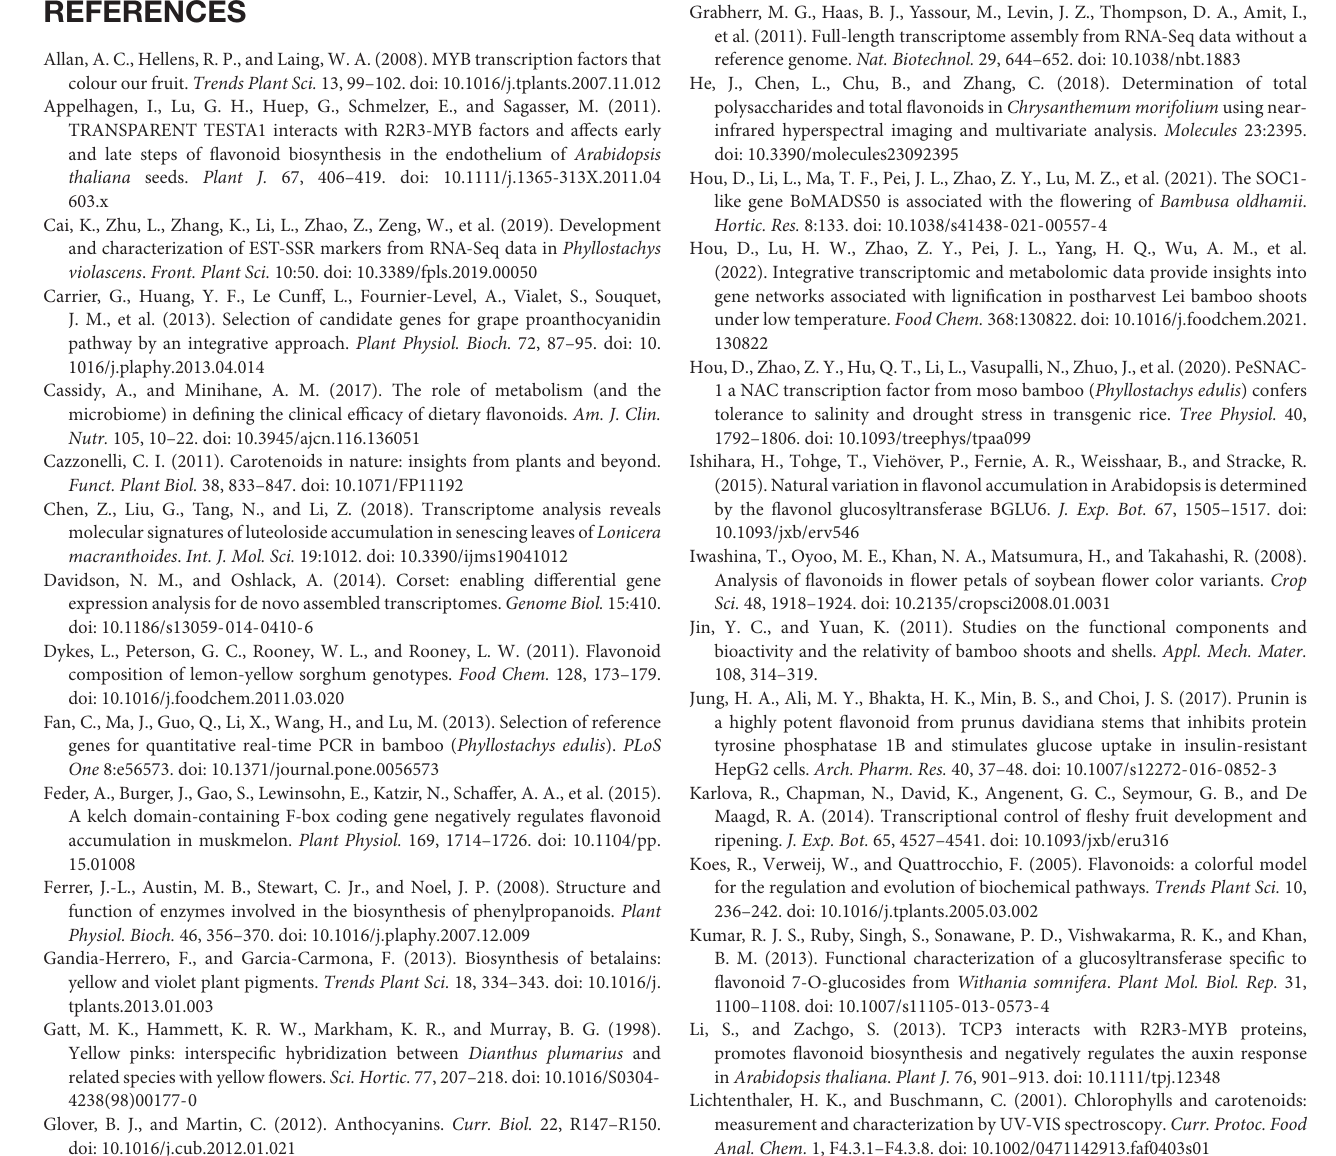
Supplementary Figure 2 | Pearson correlation coefficients between positive (A) and negative (B) quality control (QC) samples of the metabolome. Supplementary Figure 3 | Principal component analysis (PCA) analysis between positive (A) and negative (B) ionization mode of the metabolome. Supplementary Figure 4 | Summary of sample clustering. The completeness of transcripts was assessed using Benchmarking Universal Single-Copy Orthologs (BUSCO) (A) . PCA was performed on both sets (from the sulcus and culm) of samples based on gene expression profiles (B) . Supplementary Figure 5 | The volcano plot about gene expression levels about culm vs. sulcus. Supplementary Figure 6 | Functional annotation of the metabolites using the Kyoto Encyclopedia of Genes and Genomes (KEGG) database. Various